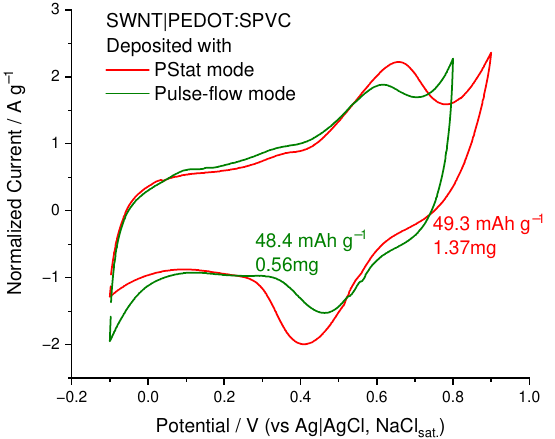
С Figure 13. CV of the PEDOT:SPVC/SWCNT electrodes deposited using PStat and pulse modes, 20 mV · s − 1 , 0.1 M HClO 4